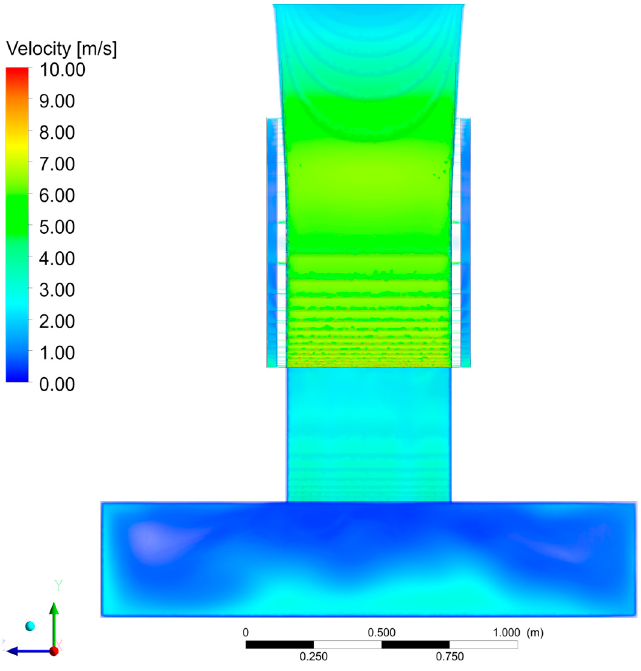
Figure 16. Velocity field in a frontal view of UL-PRS.